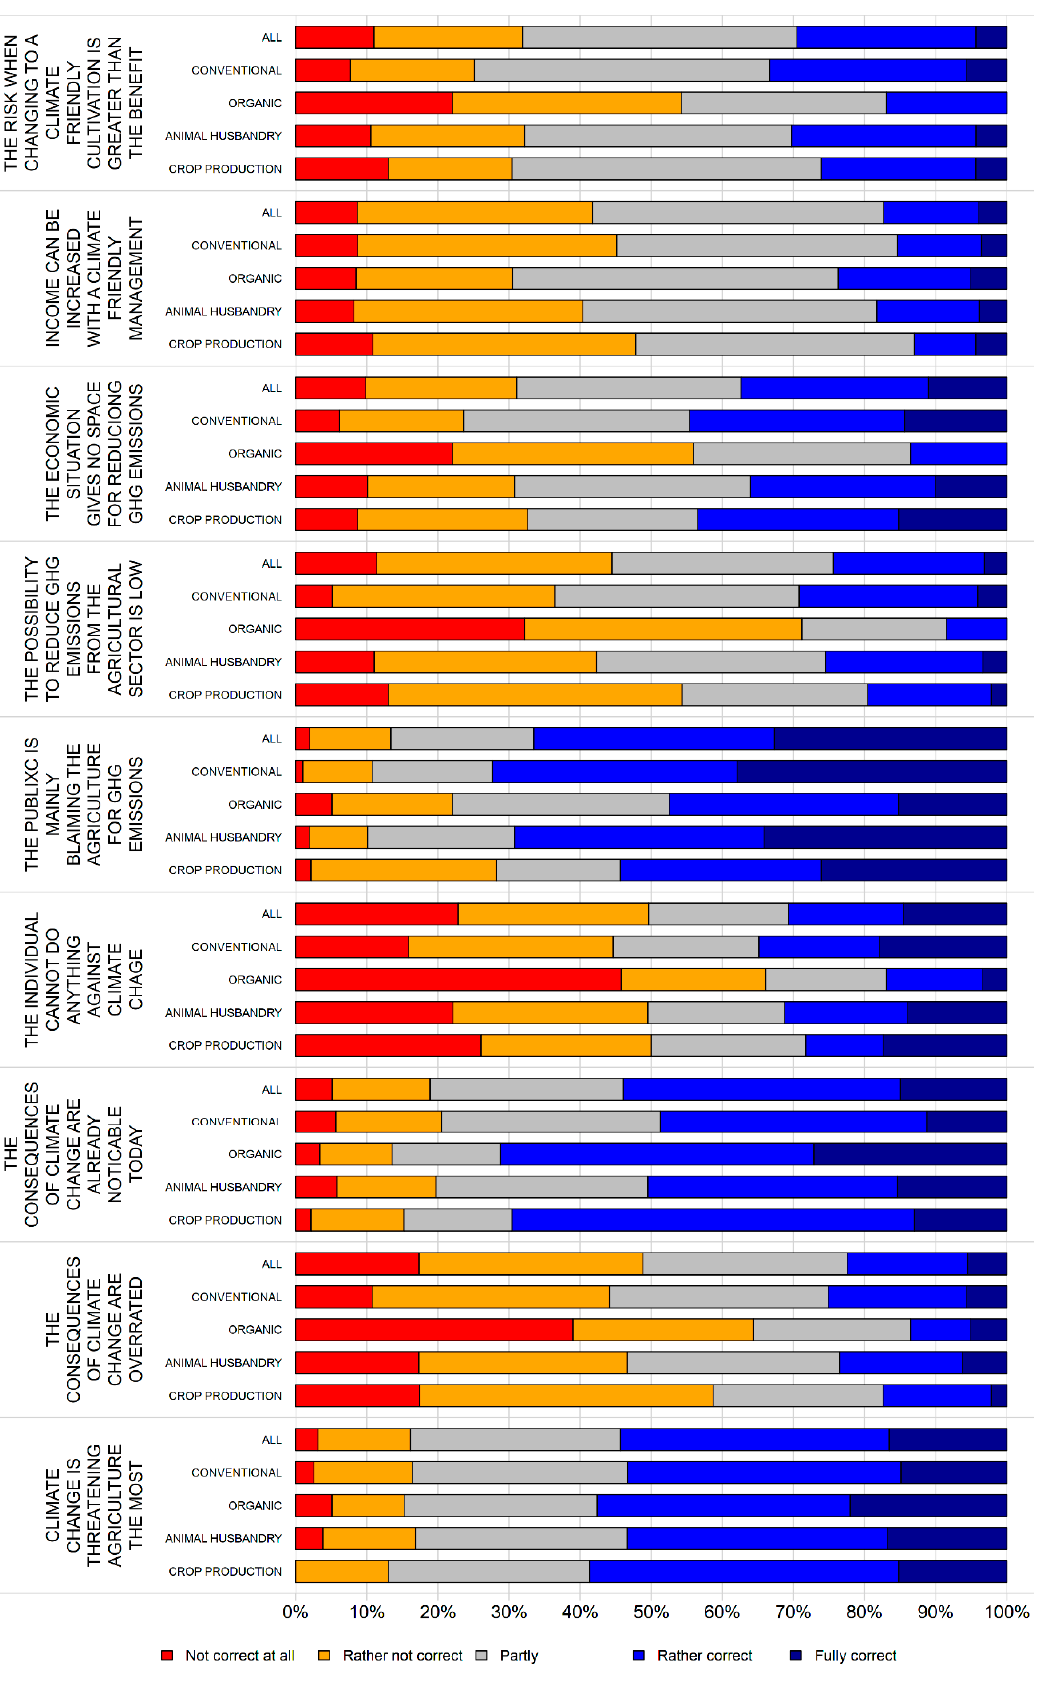
Figure 1. Farmers’ positions and attitudes towards climate change and agricultural greenhouse gas (GHG) emissions.